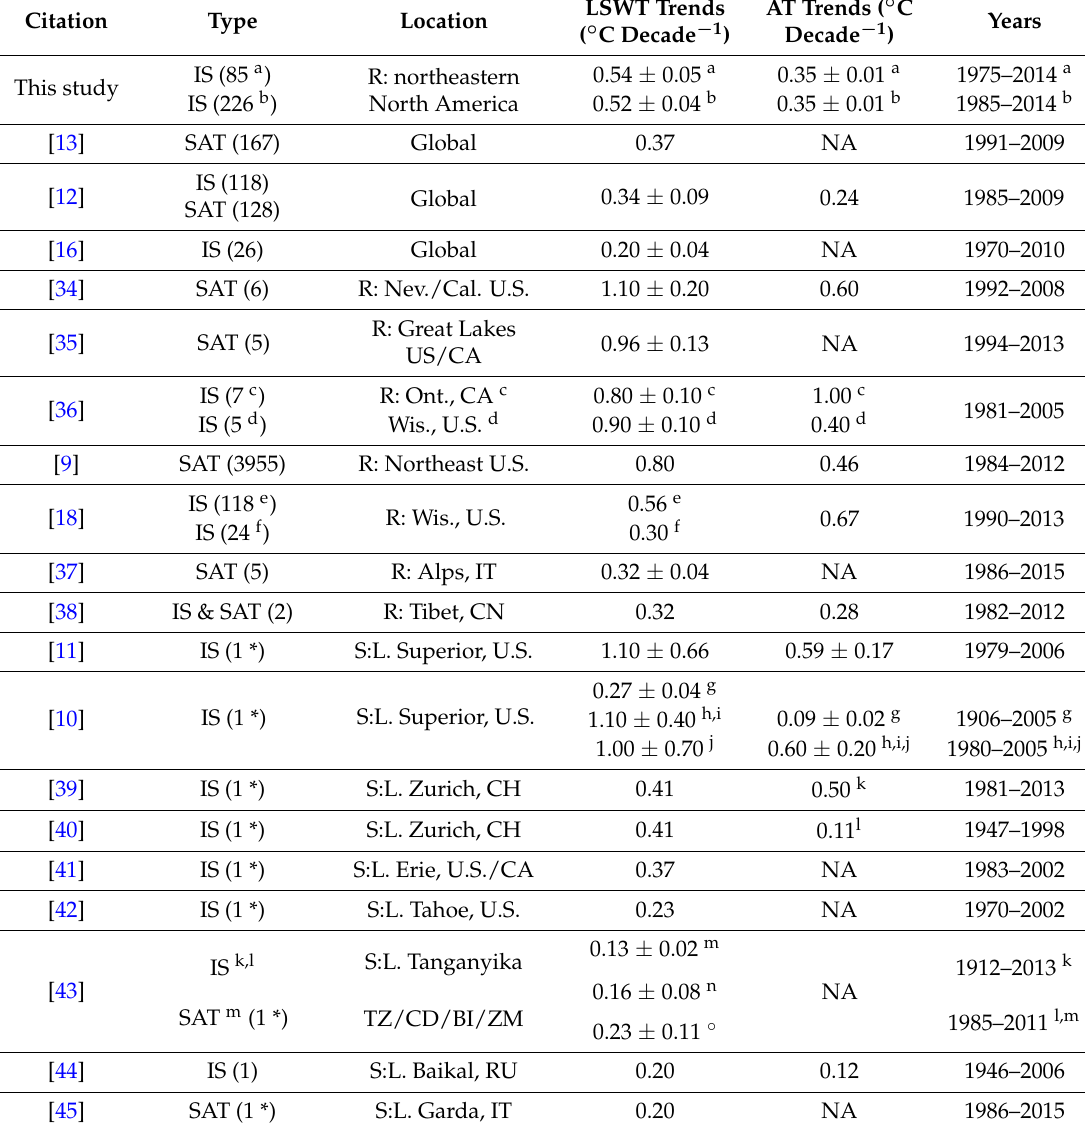
Table 2. Lake surface water temperature (LSWT) trends and corresponding air temperature (AT) in this study of northeastern North American lakes (top row) and 19 other studies of lake surface temperature trends ranging from a global suite of lakes to a single lake. Presented trends are mean ◦ C decade − 1 ± SE unless otherwise noted. “Type” indicates how measurements were taken (“IS” = in situ, “SAT” = satellite). The number following in parentheses indicates the number of lakes included in the study. “Location” indicates if the study was global, regional (“R”) or single lake (“S”), with the 2-character country code and 3-character state or province name (regional studies) or the lake name (single-lake studies). An asterisk in some single-lake studies indicates multiple sites in the lake. See footnotes for additional